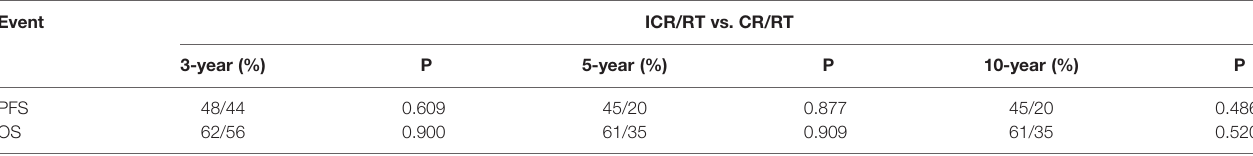
TABLE 6 | Analysis of survival data between larynx preservation treatments with or without induction chemotherapy.